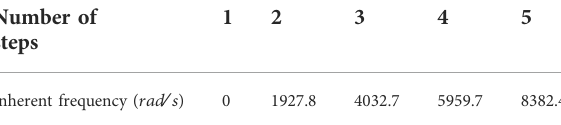
TABLE 2 Intrinsic frequency values of the crankshaft